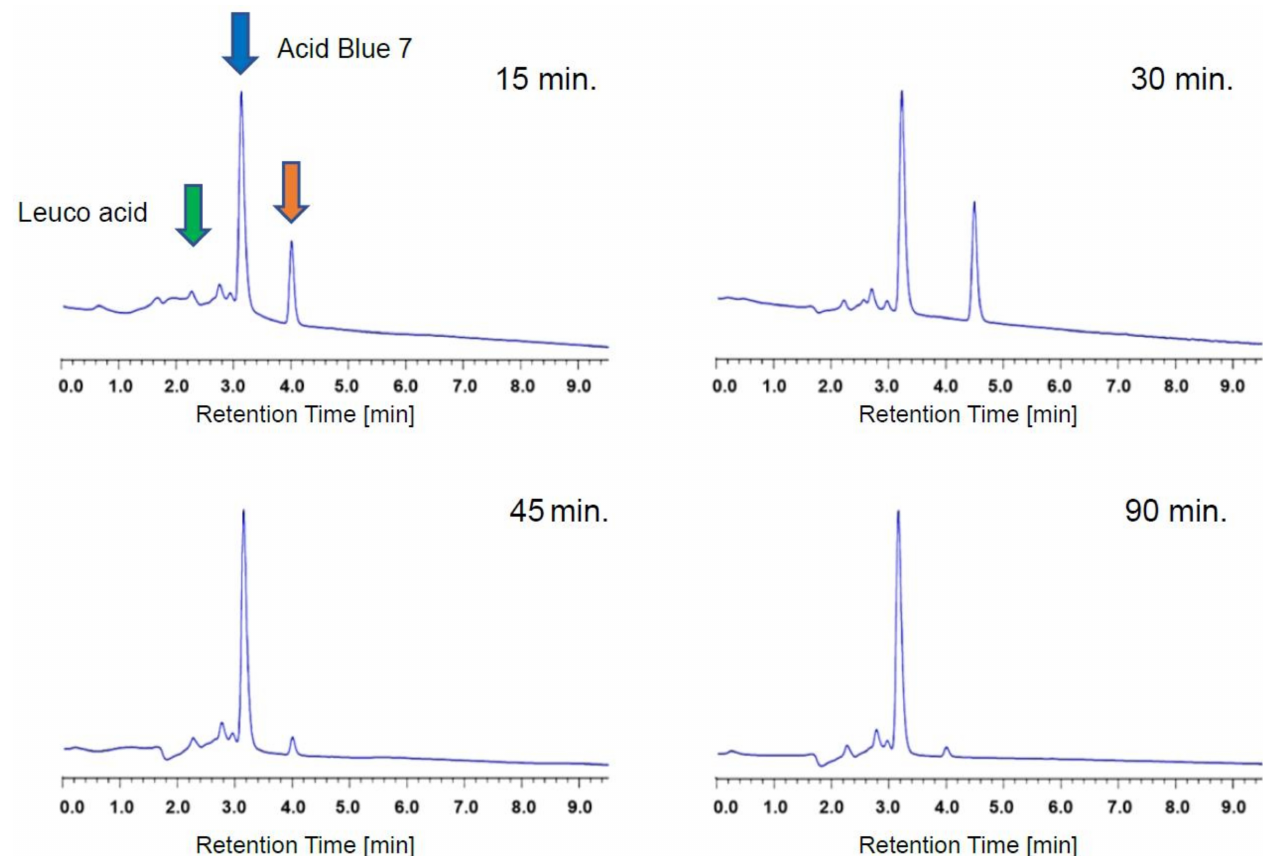
Figure 3. Time-course monitoring (15, 30, 45, and 90 min.) by